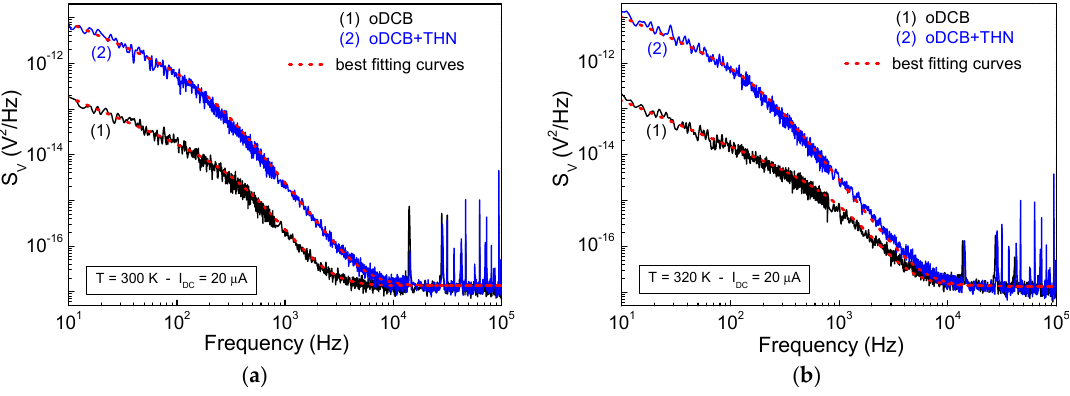
Figure 3. Low-frequency voltage-noise spectra of a device fabricated with oDCB as solvent, curves 1, and of a device fabricated with oDCB+THN as solvent, curves 2. Experimental data are measured in dark conditions at different temperatures: ( a ) T = 300 K; ( b ) T = 320 K. The dashed curves are the best fit obtained by using Equation (1).